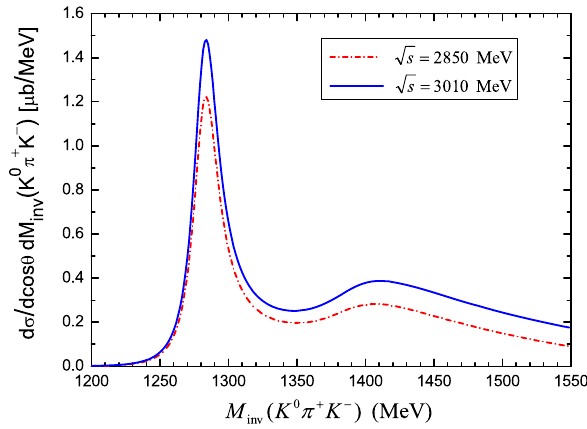
Fig. 3 Differential cross section d σ for the ¯ K 0 p → (cid:3) + K 0 π + K − reaction at ¯ K 0 energy or 3010